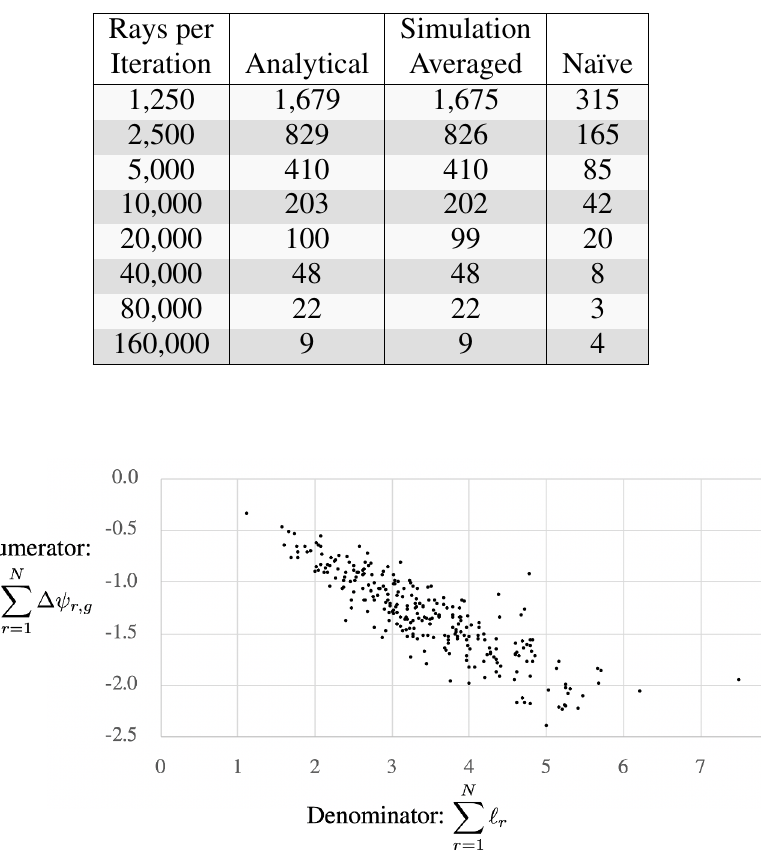
Table 2: Active iteration requirements to reach target source uncertainty level.